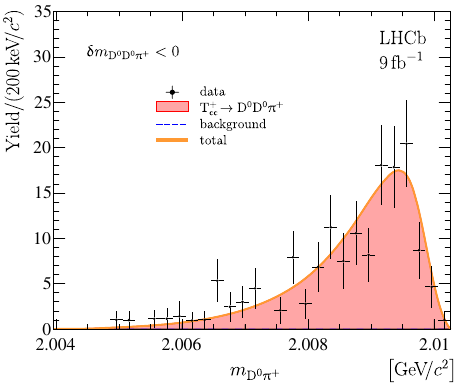
Fig. 3 Mass distribution for D 0 π + pairs. Mass distribution for D 0 π + pairs from selected D 0 D 0 π + candidates with a mass below the D * + D 0 mass threshold with non-D 0 background subtracted. The overlaid fi t result is described in the text. The background component vanishes in the fi t. Uncertainties on the data points are statistical only and represent one standard deviation, calculated as a sum in quadrature of the assigned weights from the background-subtraction